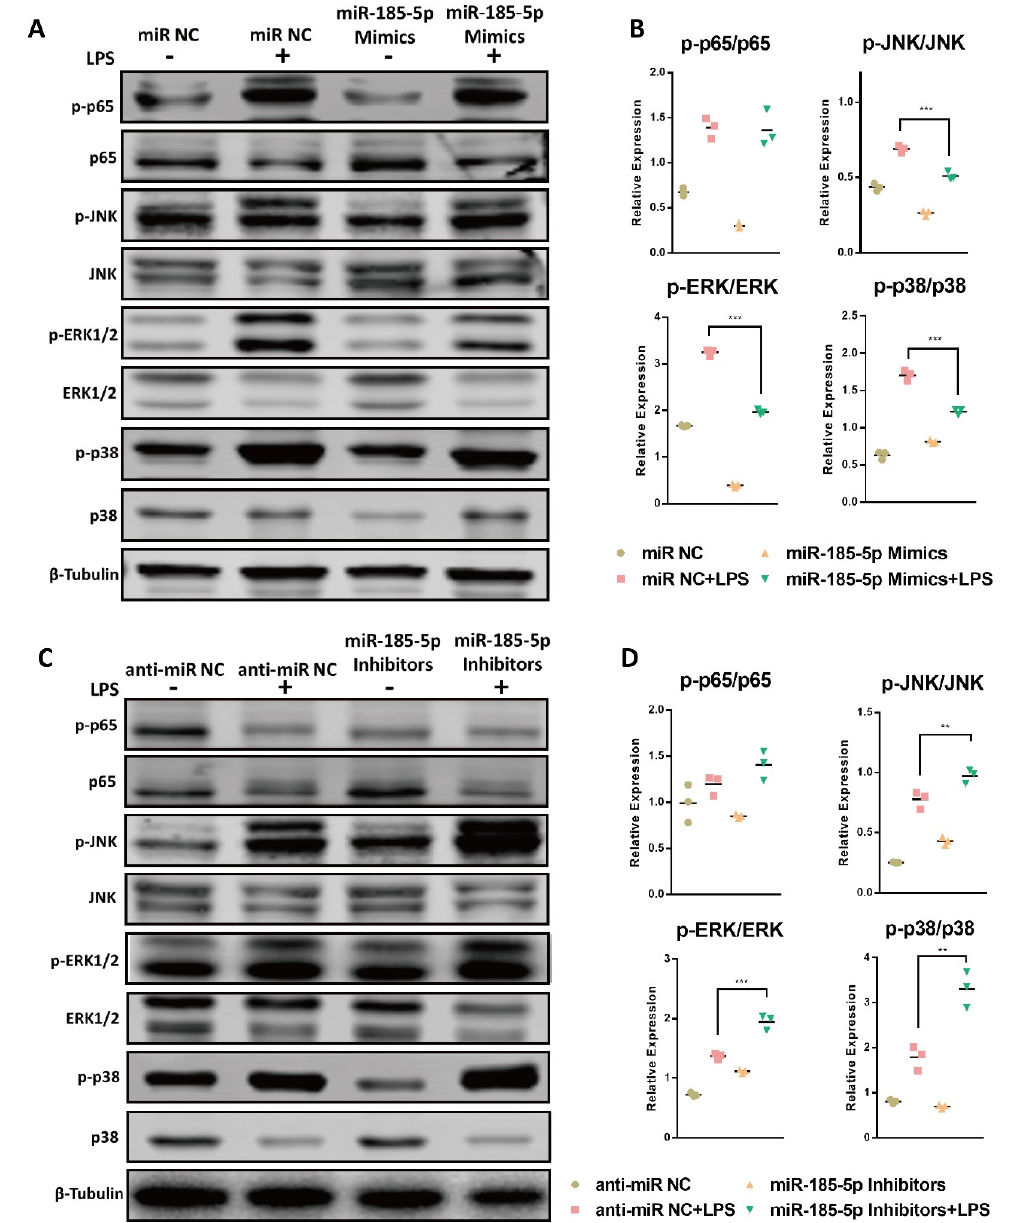
Figure 4. miR-185-5p regulates the activation of MAPK pathways. ( A ) Effects of miR-185-5p over- expression on the total and phosphorylation of p65, JNK, ERK1/2, and p38 in macrophages after treatment with or without 100 ng/mL LPS for 24 h, as determined by Western blot. ( B ) Quantification of phosphorylation and total proteins in Western blots in LPS-induced macrophages with miR-185- 5p overexpression or miR NC. ( C ) Effects of miR-185-5p knockdown on the activation of the total and phosphorylation of p65, JNK, ERK1/2, and p38 in macrophages after treatment with or without 100 ng/mL LPS for 24 h, as determined by Western blot. ( D ) Quantification of phosphorylation and